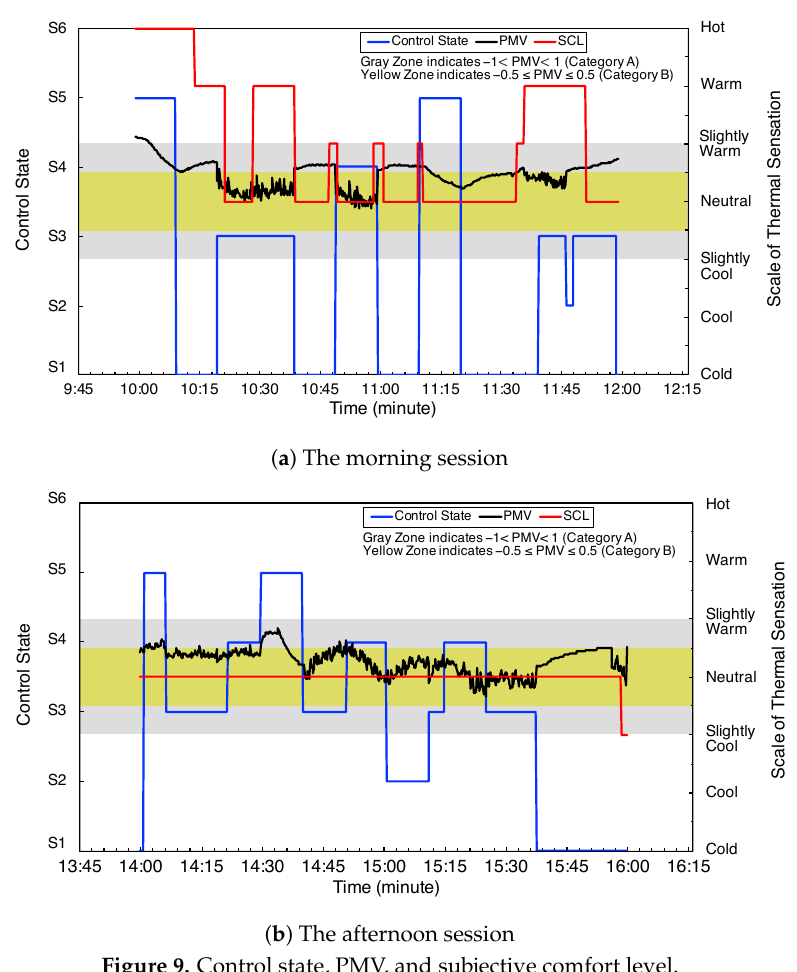
Figure 9. Control state, PMV, and subjective comfort